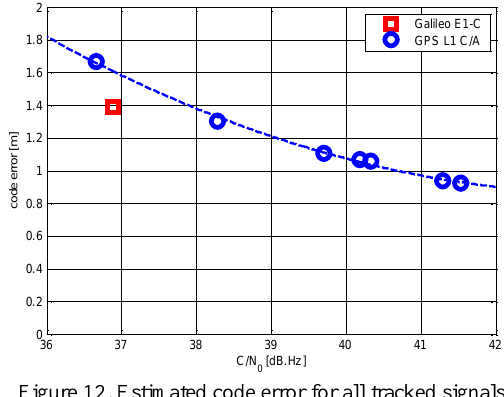
Figure 12. Estimated code error for all tracked signals